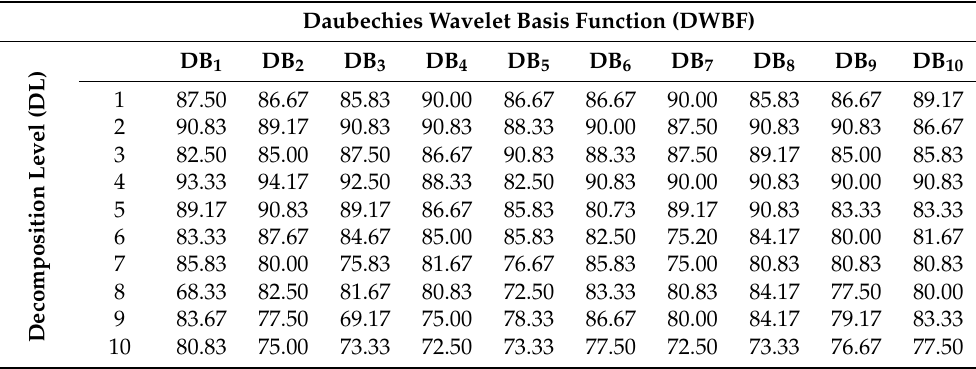
Table 5. Average accuracy (%) due to DWBF and decomposition level